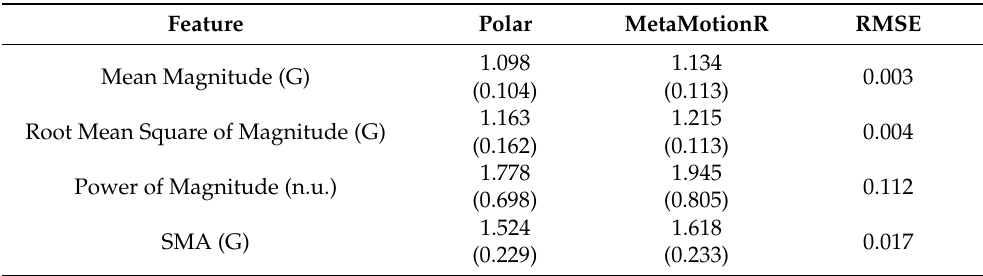
Table 4. Mean and standard deviations of correlation coefficient (r) for accelerometer data low-pass filtered at different cut-off frequencies. Cut-Off Frequency Axis 40 Hz 30 Hz 20 Hz 10 Hz X 0.891 (0.232) 0.890 (0.144) 0.889 (0.145) 0.887 (0.146) Y 0.888 (0.160) 0.887 (0.160) 0.886 (0.160) 0.884 (0.162) Z 0.908 (0.085) 0.908 (0.086) 0.906 (0.086) 0.904 (0.088) Magnitude 0.954 (0.047) 0.953 (0.047) 0.952 (0.049) 0.959 (0.051)